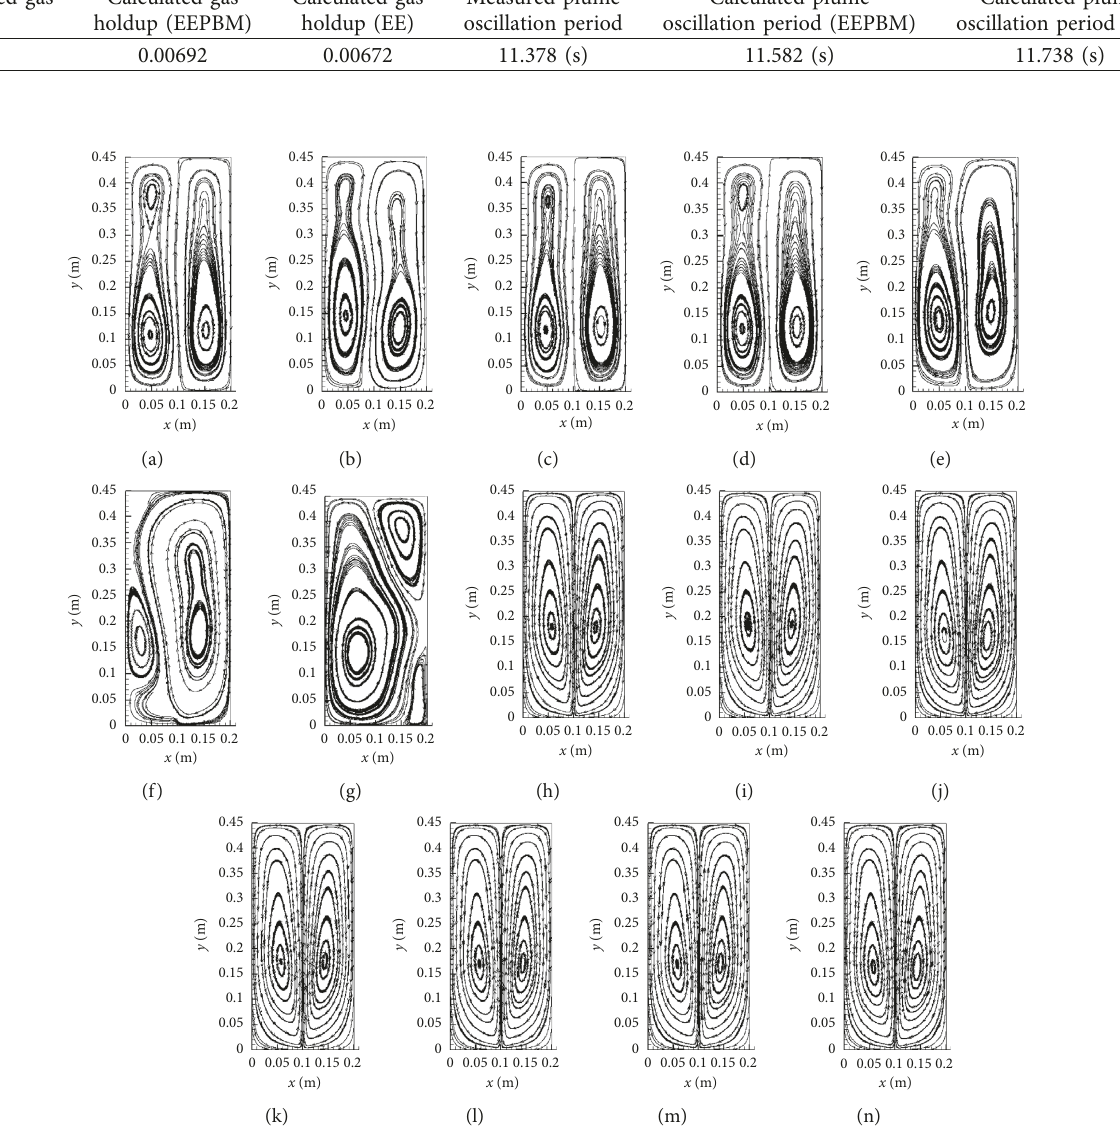
Figure 3: Time-averaged flow field of liquid phase. (a) Case 1, (b) Case 2, (c) Case 3, (d) Case 4, (e) Case 5, (f) Case 6, (g) Case 7, (h) Case 8, (i) Case 9, (j) Case 10, (k) Case 11, (l) Case 12, (m) Case 13, and (n) Case